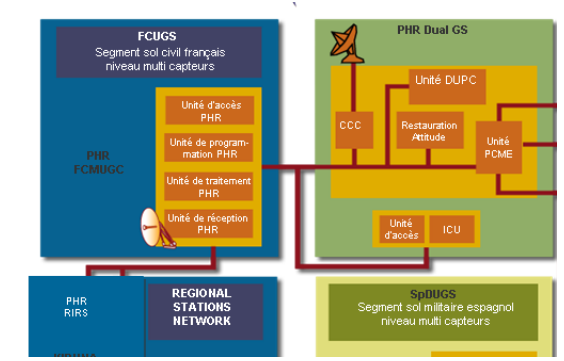
Figure 4: Ground segment